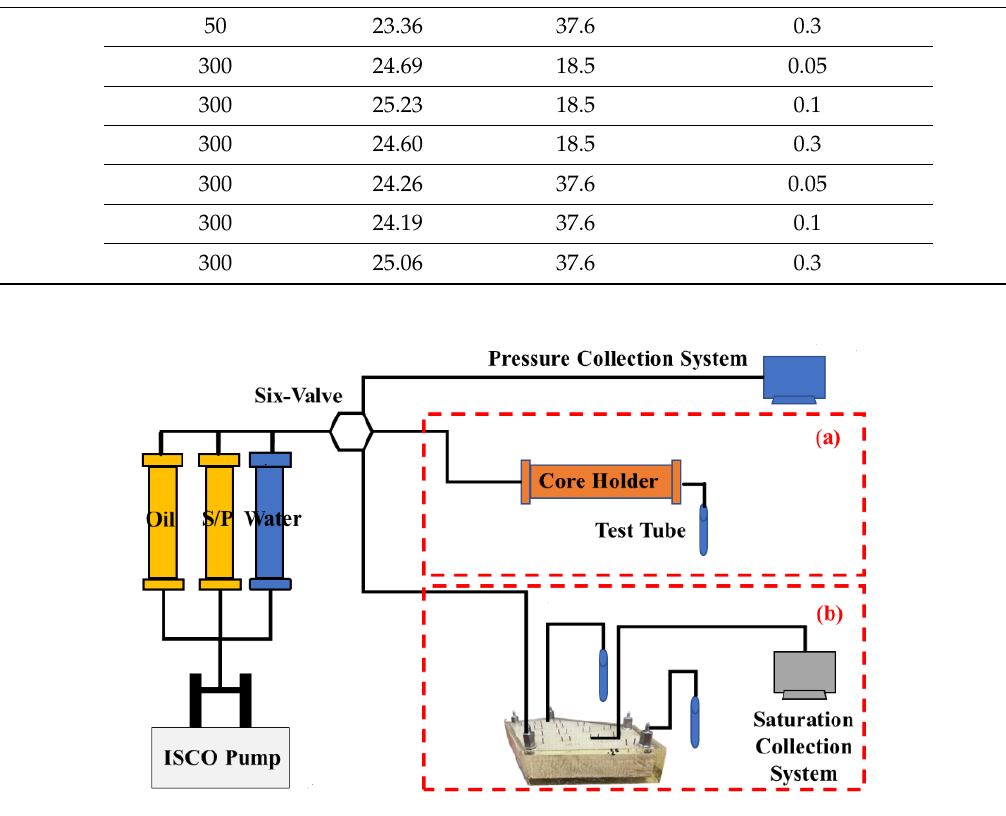
Figure 3. Diagram of the displacement for EOR efficiency of S/P flooding in ( a ) the cylinder core and ( b ) the plate core. Table 3. The scheme of the displacement efficiency experiments.